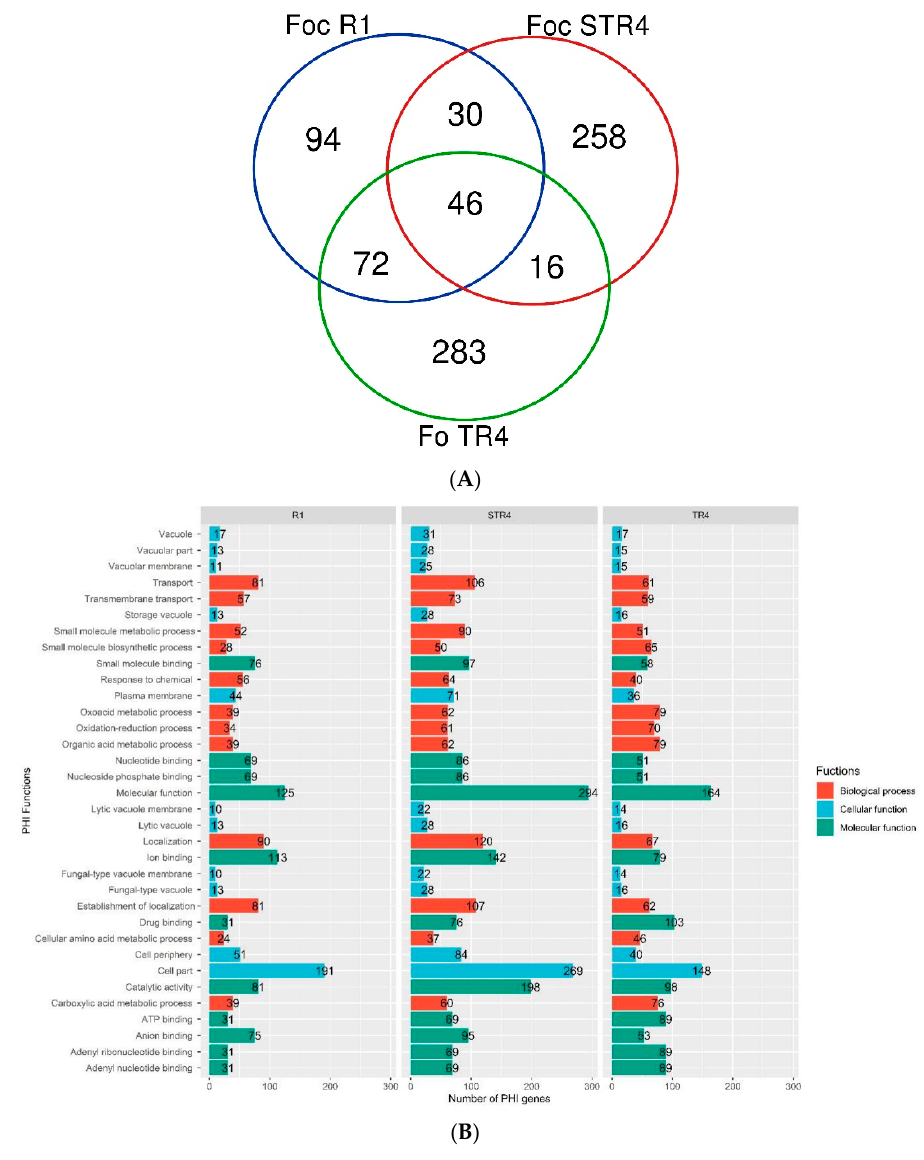
Figure 4. ( A ) Venn diagram of the putative virulence-associated genes identified in the comparisons of Foc R1 vs. Foc STR4 vs. Foc TR4. ( B ) Number and functions of PHI genes present in the Indian Foc